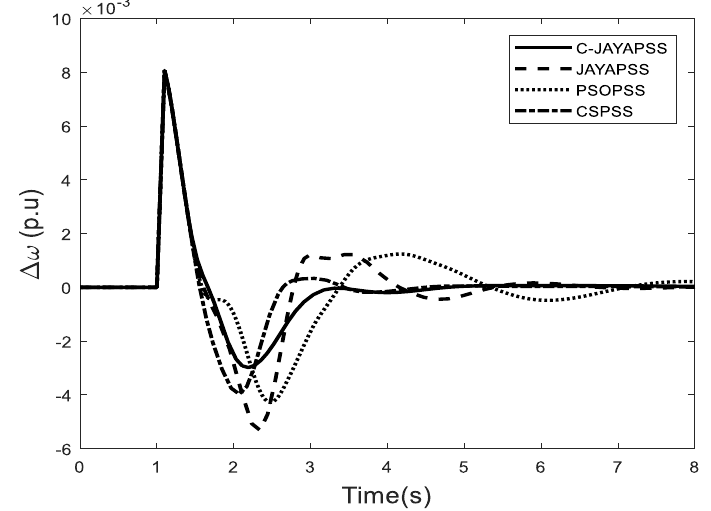
Figure 13. Rotor speed response for a six-cycle fault disturbance with case 4.